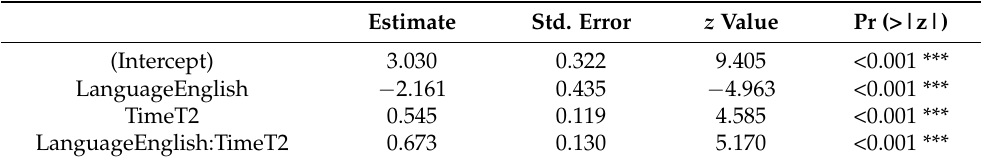
Table A4. Coefficients of the fixed effects of the logistic mixed-effects regression comparing perfor- mance in English and Arabic at T1 and T2 for the whole sample.